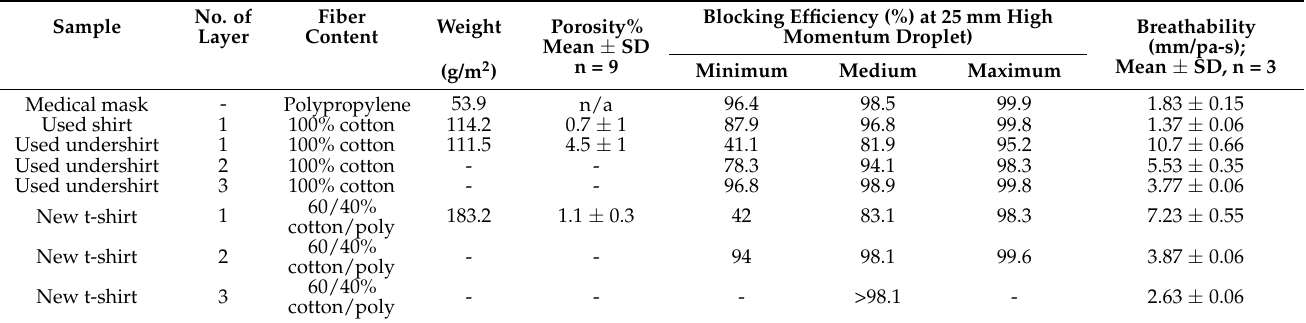
Table 1. Sample details and performance parameters of face coverings reproduced from